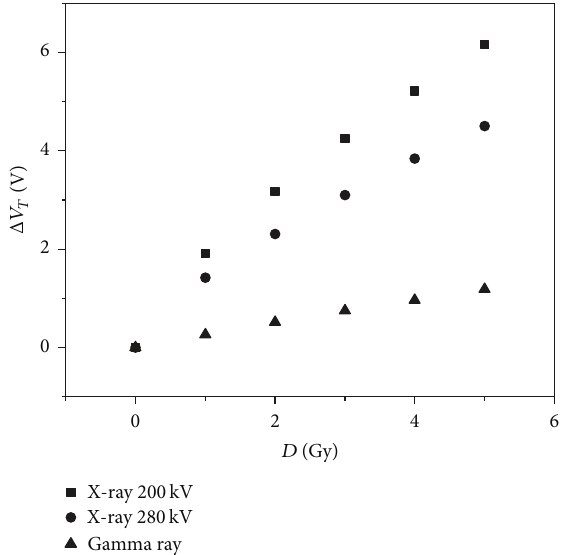
Figure 7: Δ𝑉 𝑇 during 200kV and 280 kV X-ray as well as gamma- ray irradiation with +5 V gate